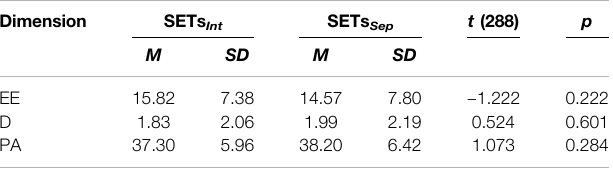
TABLE 9 | Differences in means in the three dimensions of burnout between the two subgroups. Dimension SETs Int SETs Sep